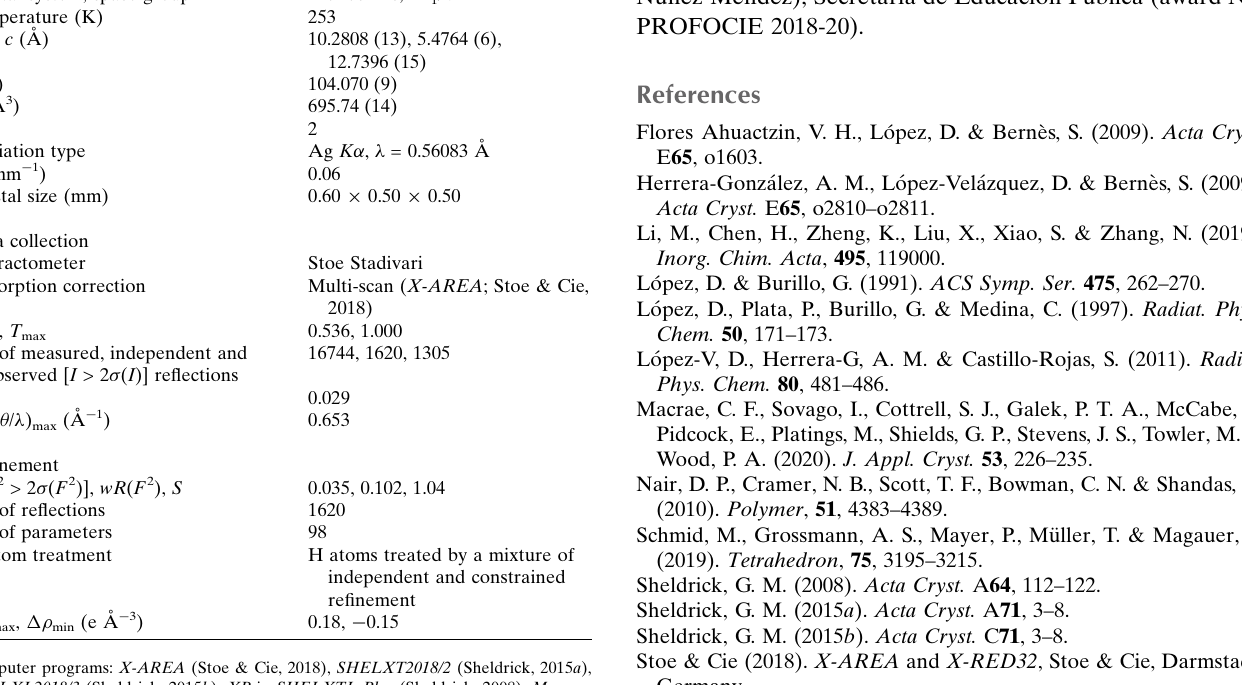
Crystal data Chemical